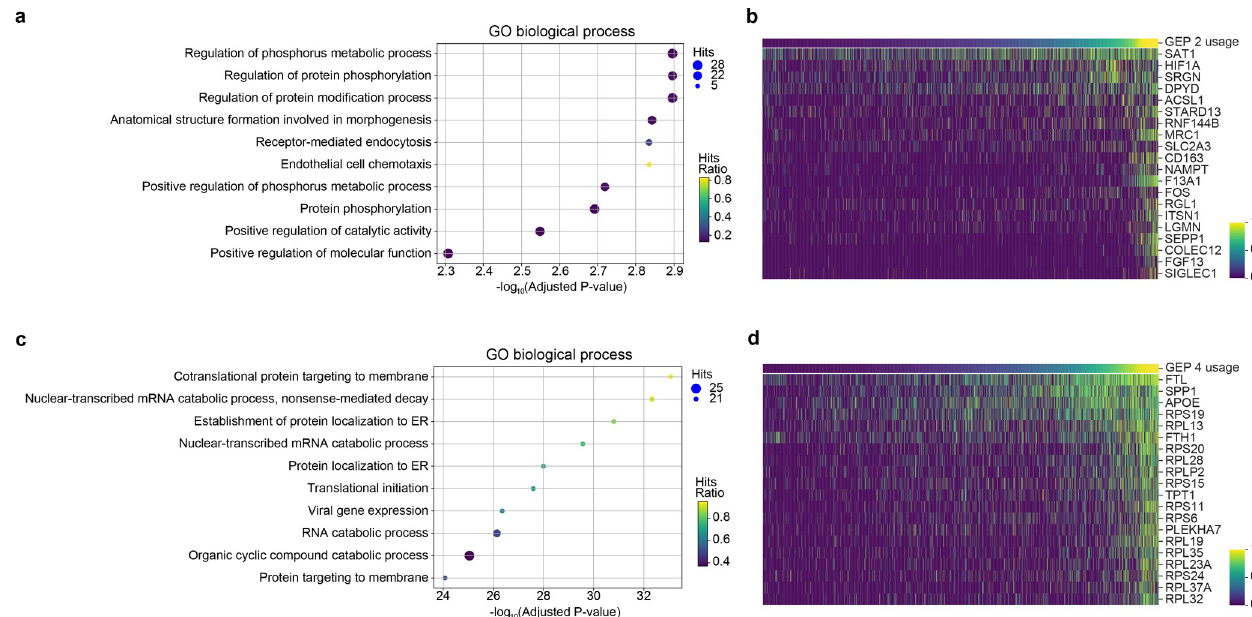
Fig 10. Enriched GO terms and top DEGs of GEP 2 and GEP 4 in the prefrontal cortex dataset. (a) The top 10 enriched GO biological process terms using upregulated DEGs in GEP 2. (b) The expression levels of the top 20 DEGs with the largest z-scores covaried with the inferred usage of GEP 2. (c) The top 10 enriched GO biological process terms using upregulated DEGs in GEP 4. (d) The expression levels of the top 20 DEGs of GEP4 covaried with the inferred usage of GEP 4. Cells in b and d were sorted by increasing order of the inferred cell usage of GEP 2 and GEP 4, respectively.